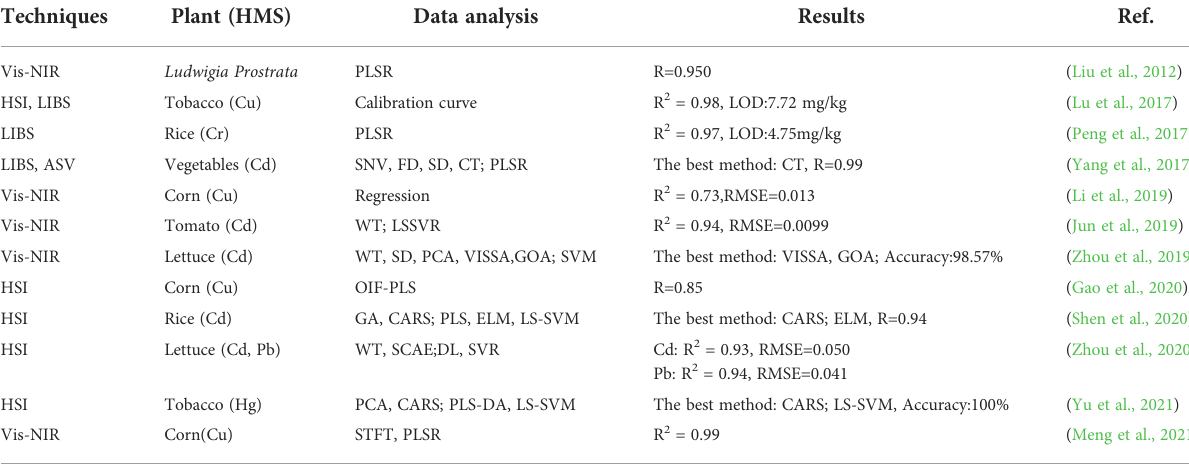
TABLE 2 Application of spectral technologies in detecting the quality of the leaves under